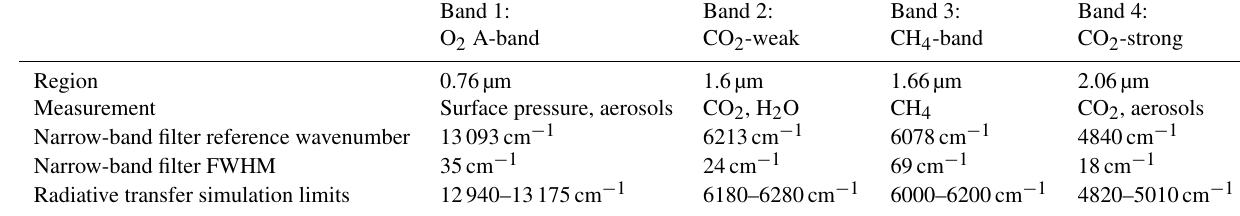
Table 1. NanoCarb spectral band characteristics.